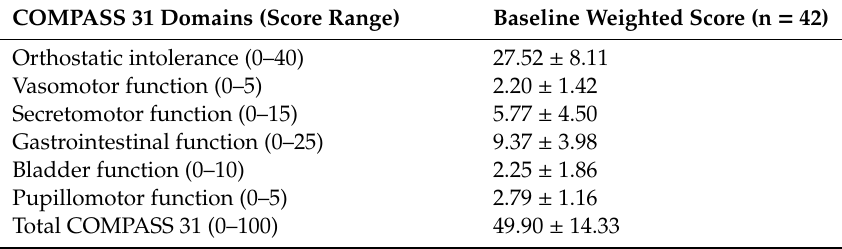
Table 2. COMPASS 31 weighted scores at baseline for the study